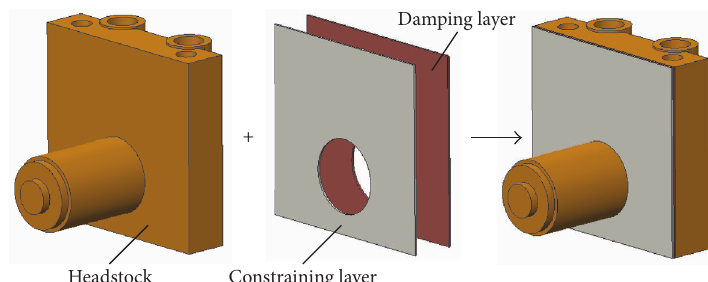
Figure 9: Hybrid headstock with damping material.